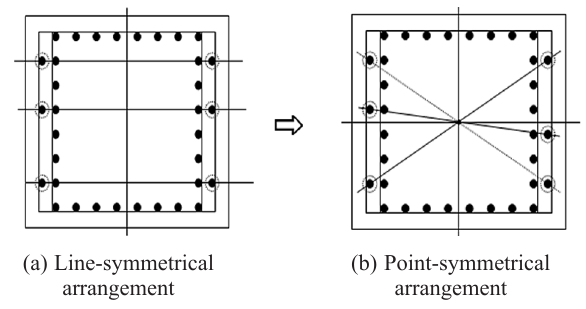
(a) Line-symmetrical arrangement Fig. 19. Arrangements of anchoring rebar